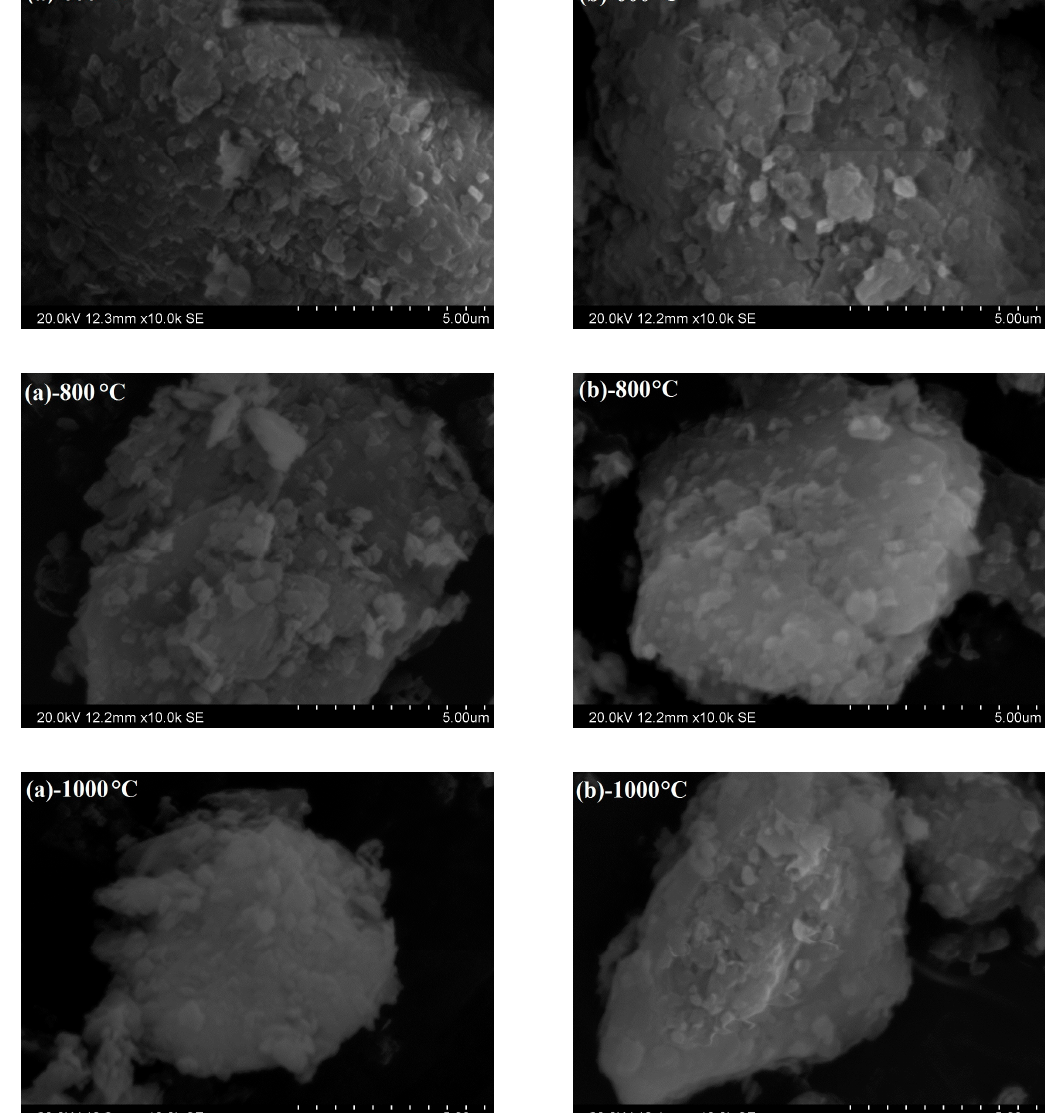
Figure 10. Scanning Electron Microscope images of calcined products by fluidized calcination ( a ) and static calcination ( b ) at different temperatures.